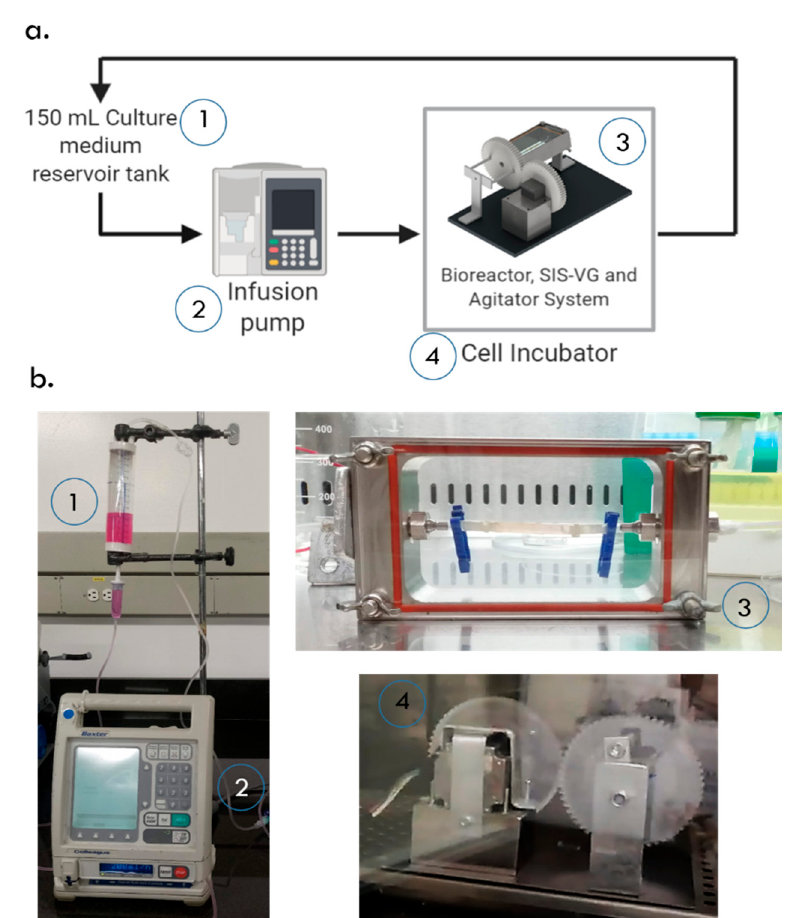
Figure 3. Fluidic system setup. ( a ) Schematic of the fluidic device and the required accessories for cell seeding on the SIS-based vascular graft. ( b ) Picture of the actual implementation components where (1) is the culture medium reservoir tank, (2) is the infusion pump, (3) is the setup of the fluidic device and a SIS-based VG, and (4) is the agitator system.